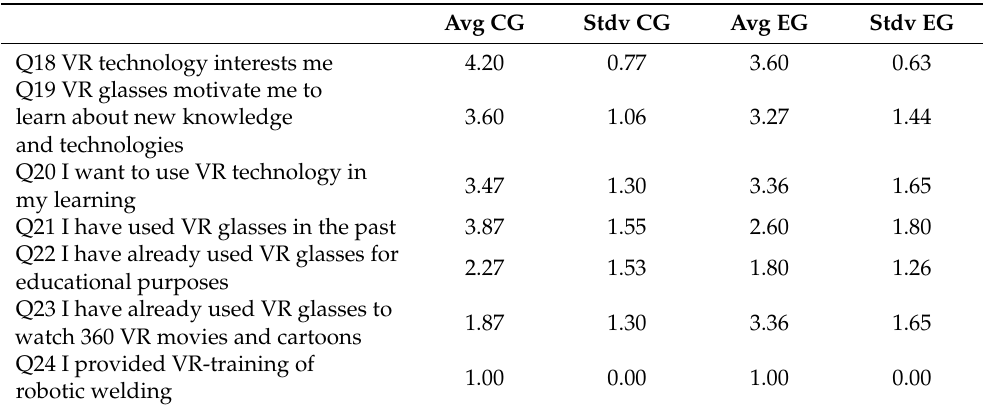
Table 5. Students attitude to VR